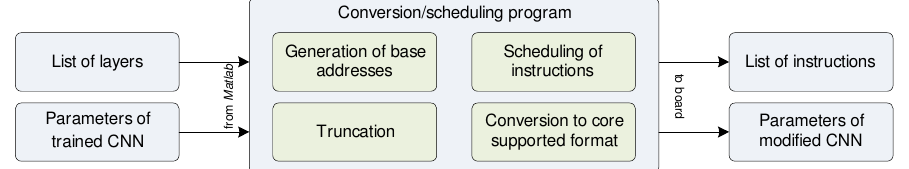
Figure 4. A schematic diagram of the program that converts a floating-point CNN to a fixed-point version for implementation on the CNN